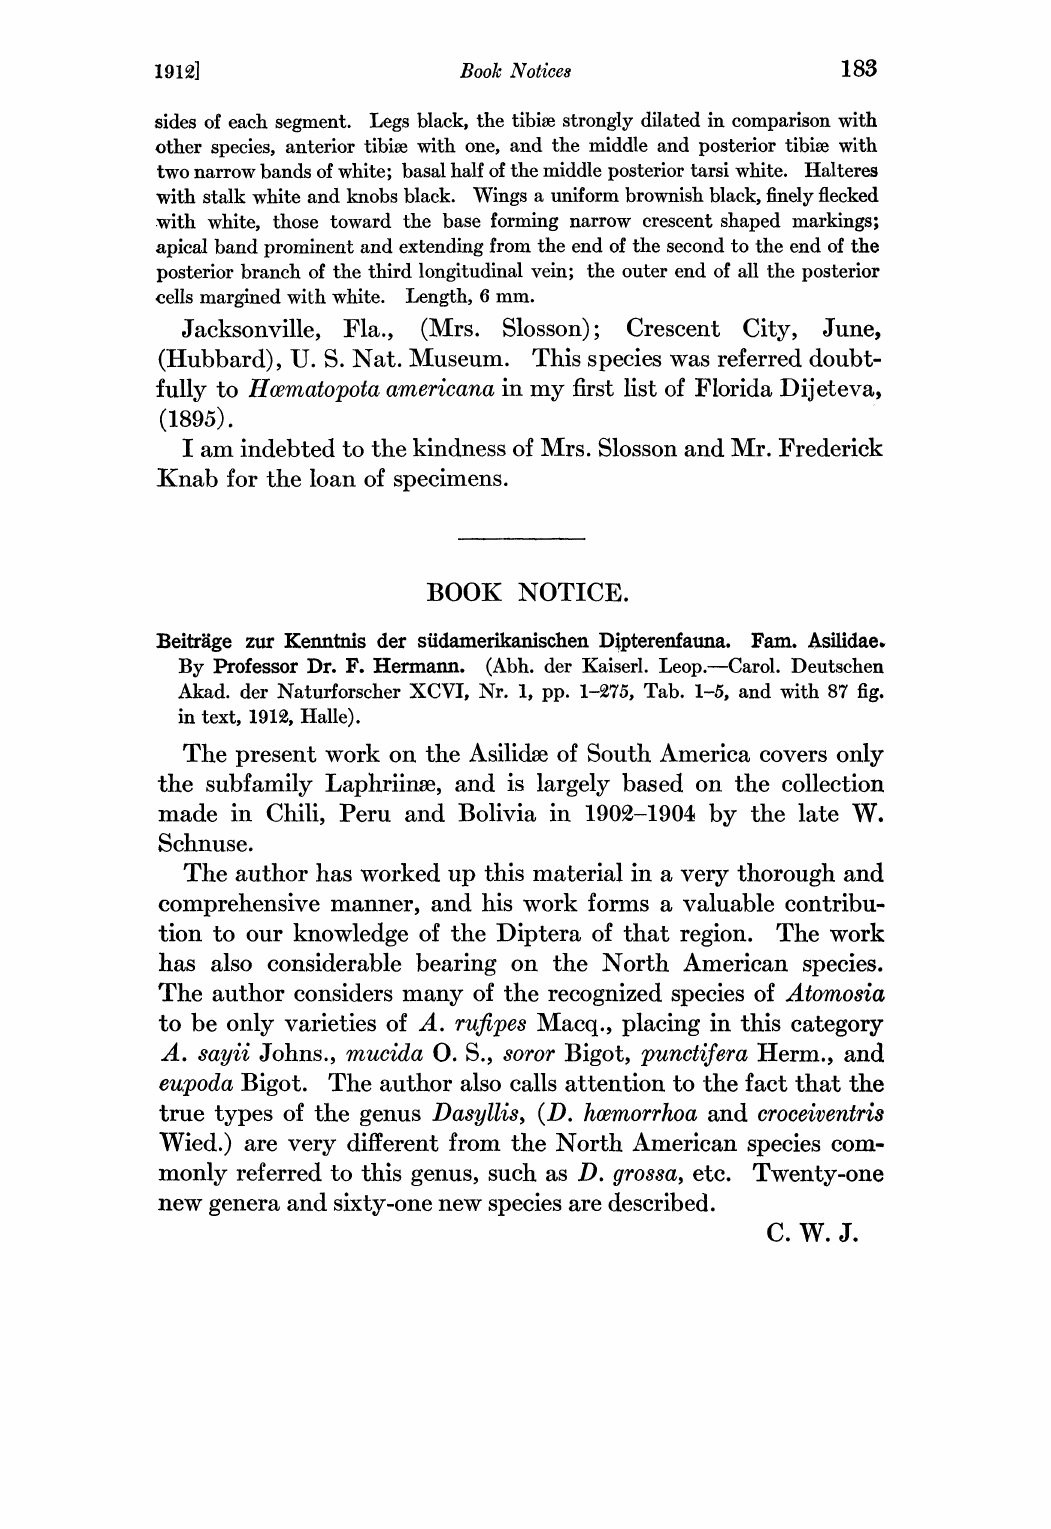
Book Notices 183 sides of each segment. Legs black, the tibiae strongly dilated in comparison with other species, anterior tibiae with one, and the middle and posterior tibiae with two narrow bands of white; basal half of the middle posterior tarsi white. Halteres with stalk white and knobs black. Wings a uniform brownish black, finely flecked with white, those toward the base forming narrow crescent shaped markings; apical band prominent and extending from the end of the second to the end of the posterior branch of the third longitudinal vein; the outer end of all the posterior cells margined with white. Length, 6